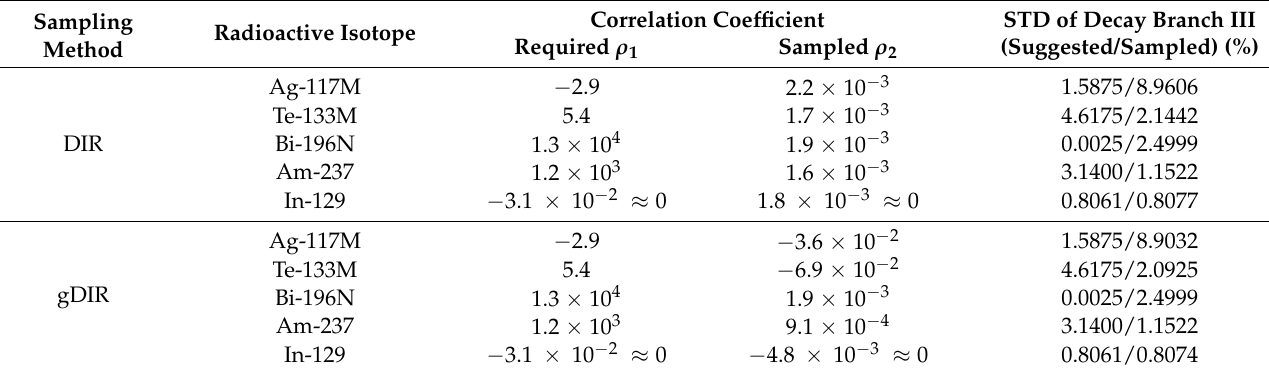
Table 3. Correlation coefficient of outliers in DIR and gDIR